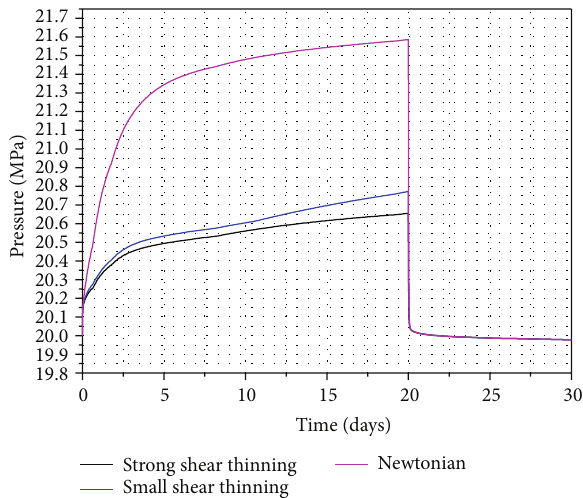
Figure 3: Log-log plot of the well bottom pressure and pressure derivative of the pressure fall-off period for various injection polymer concentrations.